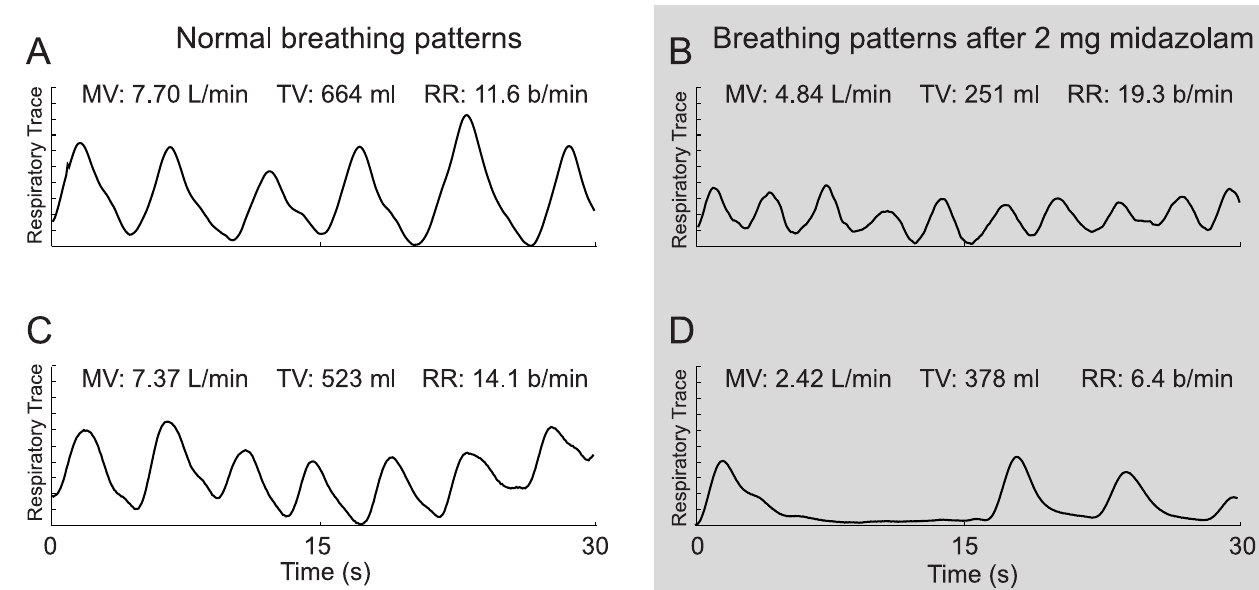
Fig 3. Examples of two different patterns of respiratorydepression in two representative subjects. Panels A and B: 31 y/o male, 185 cm, 82 kg, BMI: 24 kg/m 2 . Panels C and D: 61 y/o female, 173 cm, 82 kg, BMI: 27 kg/m 2 . Comparison of traces before ( A and C ) and after ( B and D ) benzodiazepineadministration shows that respiratory depression may manifest as both tachypneawith low TV ( B ) as well as intermittent apnea ( D ).